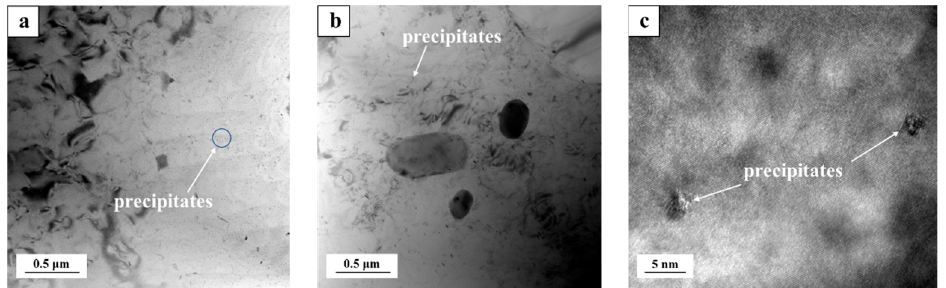
Figure 12. Bright-field TEM diagram of Cd-containing alloys after heat treatment: ( a ) two-stage solution treatment, ( b ) three-stage solution treatment, and ( c ) high-resolution TEM of precipitates.